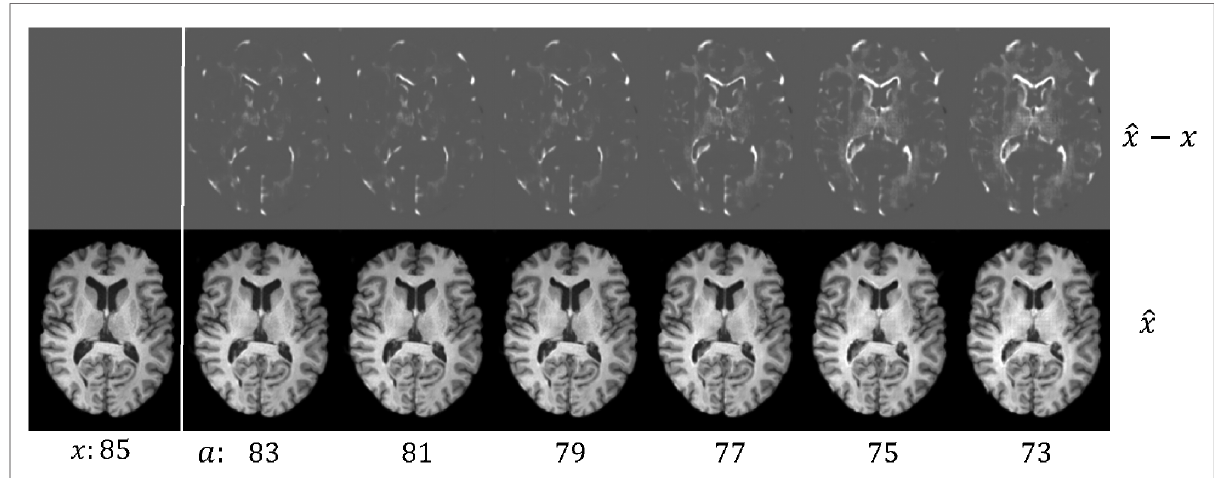
FIGURE 4 Example results of brain rejuvenation for an image ( x ) of a 85 year old CN subject. We synthesise rejuvenated images ^ x at different target ages a . We also show the differences between ^ x and x , ^ x (cid:4) x . For more details see